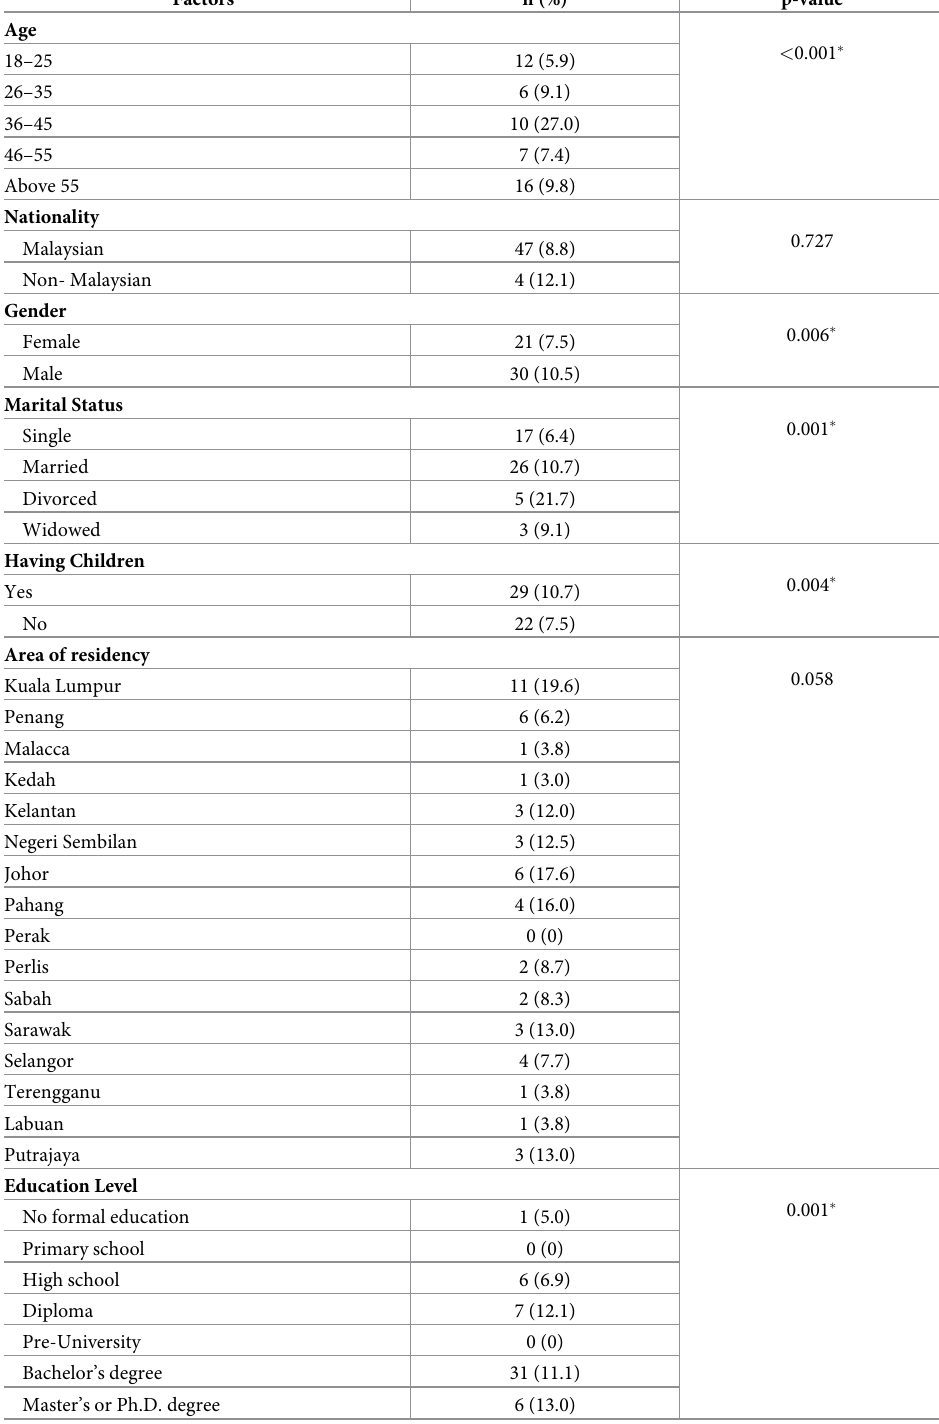
Table 5. Factors associated with the use of drive-thru community pharmacy services among the general popula- tion using Univariable analysis (N =